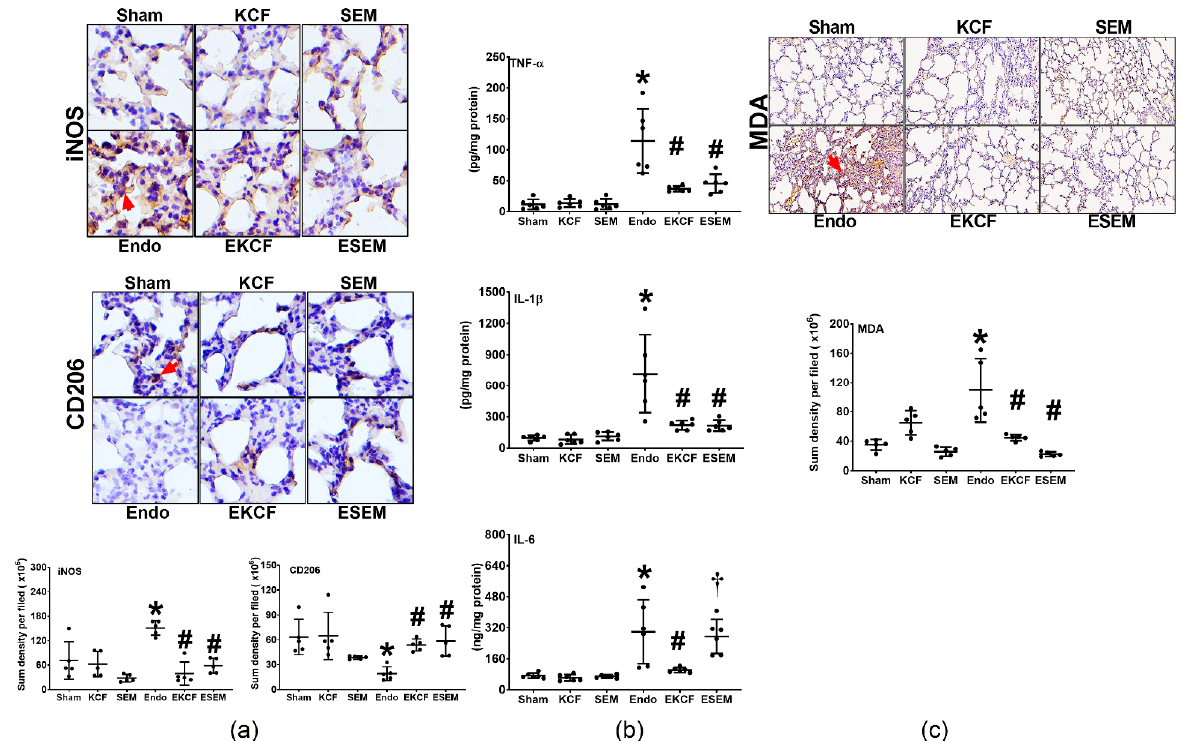
Figure 5. Lung inflammation and oxidation status. ( a ) Representative microscopic images of inducible nitric oxide synthase (iNOS, the indicator of M1 phase polarization; marked by the red arrow, 200 × ) and CD206 (the indicator of M2 phase polarization; marked by the red arrow, 200 × ) in lung tissues assayed using immunohistochemistry analysis and the sum of the iNOS and CD206 signal intensities. Data were obtained from five mice in each group. ( b ) The concentrations of tumor necrosis factor- α (TNF- α ), interleukin-1 β (IL-1 β ), and interleukin-6 (IL-6) in lung tissues. Data were obtained from six mice in each group. ( c ) The concentrations of malondialdehyde (MDA, the indicator of oxidation) in lung tissues. Data were obtained from five mice in each group. All assays were measured at 24 h after endotoxin or normal saline administration. Sham: the normal saline group. KCF: the normal saline plus the KCF18 peptide group. SEM: the normal saline plus the SEM18 peptide group. Endo: the endotoxin group. EKCF: the endotoxin plus the KCF18 peptide group. ESEM: the endotoxin plus the SEM18 peptide group. Data were presented as the mean ± standard deviation. * p < 0.05, versus the Sham group. # p < 0.05, versus the Endo group. † p < 0.05, the ESEM group versus the EKCF group.